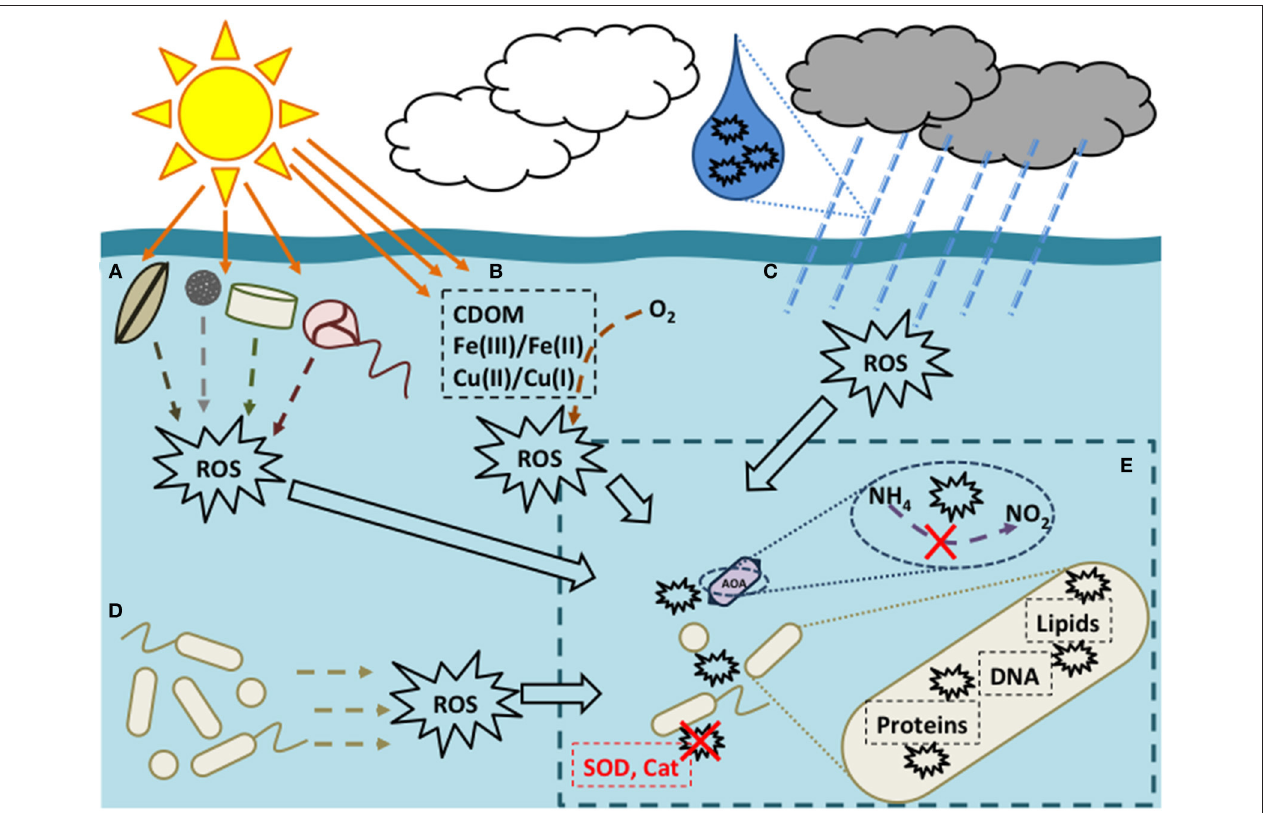
FIGURE 1 | Sources (A–D) and effects (E) of reactive oxygen species (ROS) in marine environments. ROS (here, superoxide and hydrogen peroxide) can be introduced in surface waters (Kieber et al., 2003) via (A) phytoplankton as by-products of photosynthesis, (B) photochemical reactions of colored dissolved organic matter (CDOM) and metals, (C) atmosphere exchange and rain, and (D) production by heterotrophic bacteria (beige). Inset (E) gives a cellular-level view of ROS toxicity: when prokaryotic cells come into contact with ROS, molecules such as DNA, protein, and lipids can become damaged unless enzymes like superoxide dismutase (SOD) or catalase (Cat) are produced to detoxify ROS (Imlay, 2008; detoxification indicated by a red X). As shown in the text, ammonia oxidation by marine Thaumarchaeota (AOA) can be sensitive to ROS.